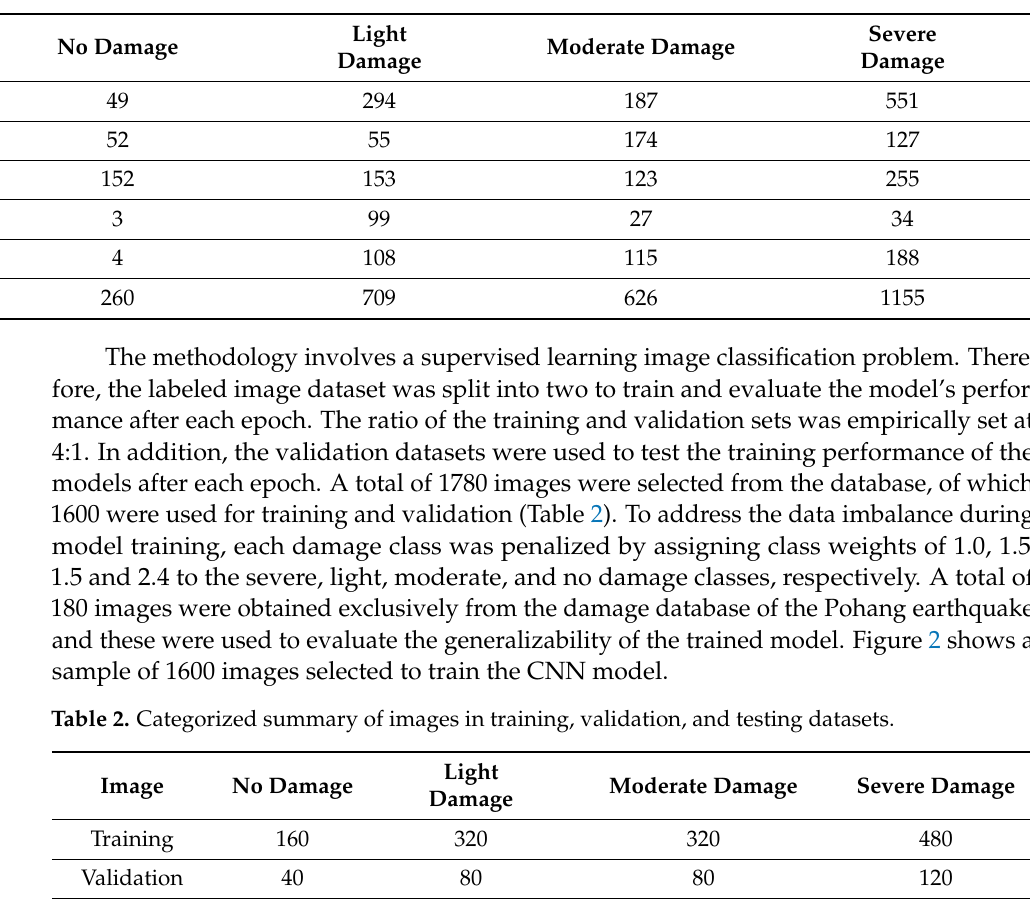
Table 1. Categorized summary of the image dataset.